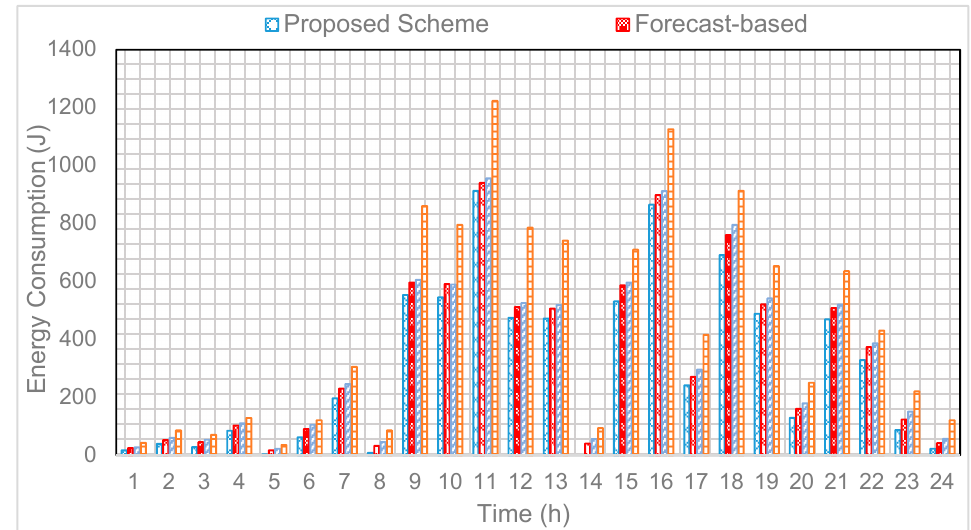
Figure 5. Energy consumption of sensors compared to relay and forecast-based schemes. Sensors 2020 , 20 , x FOR PEER REVIEW